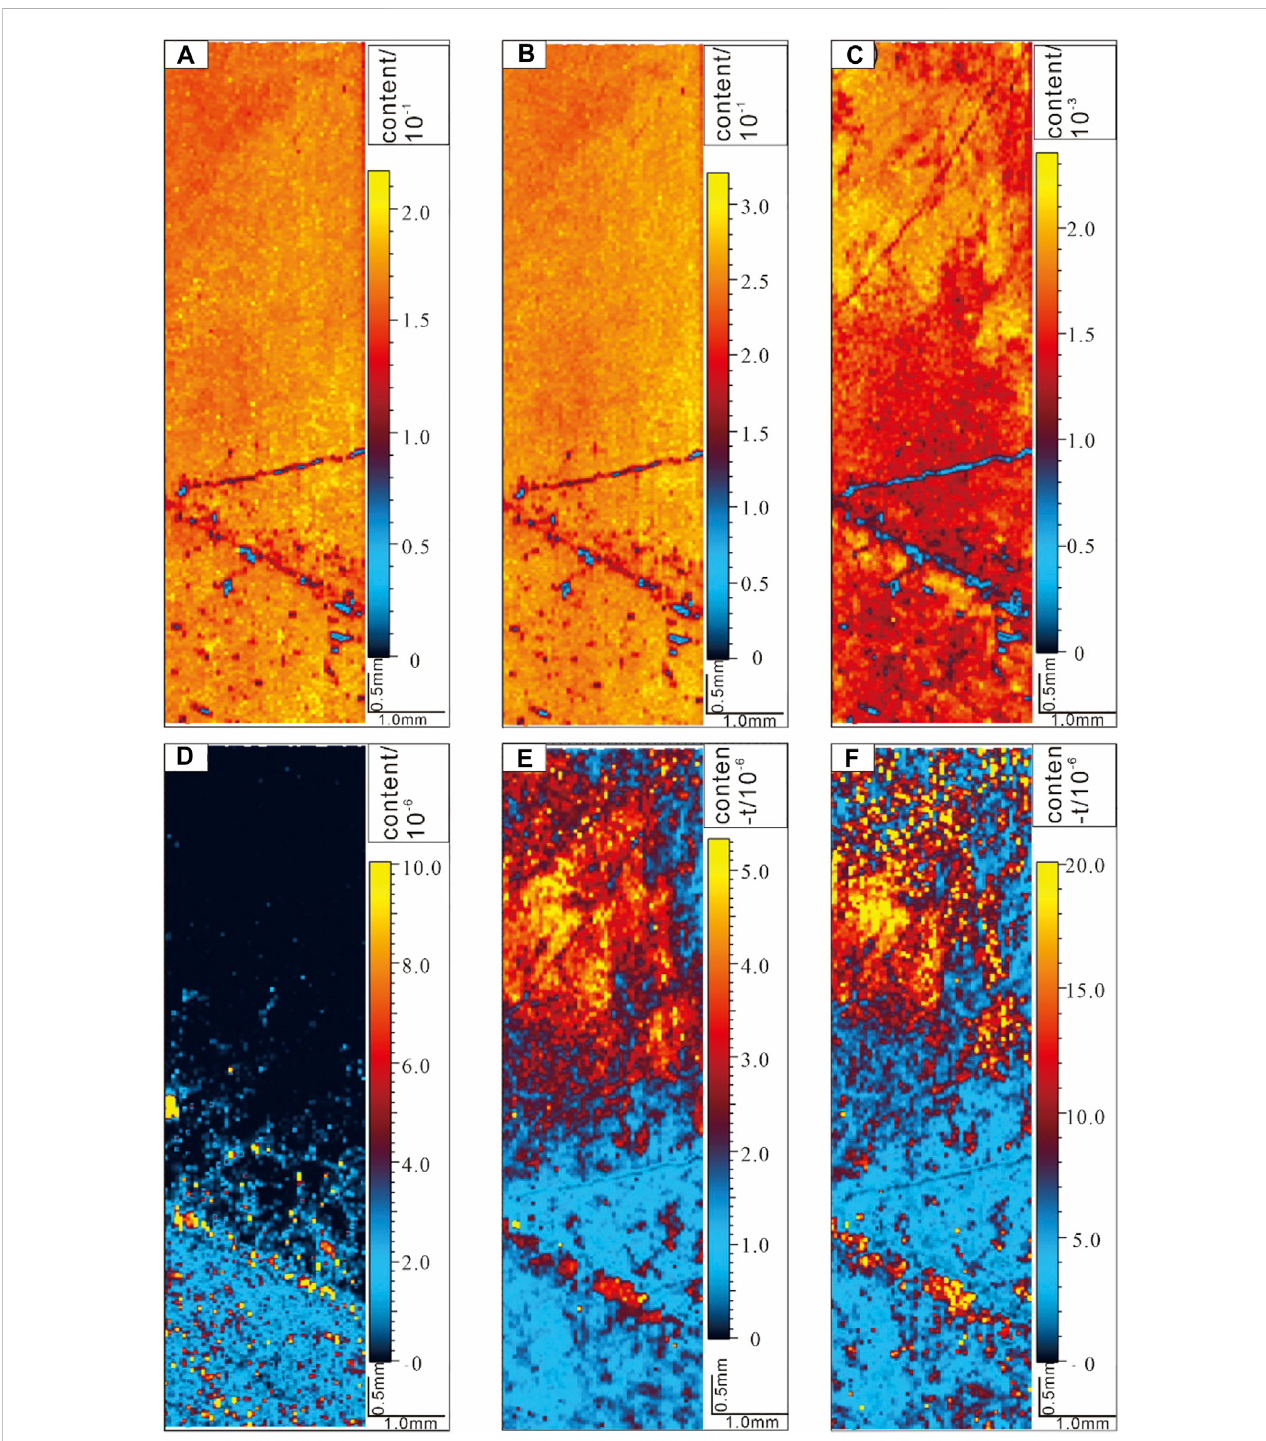
FIGURE 5 Element surface scanning images of Sample DQ11 in the Tarim Basin. (A) . Concentration of 25 Mg in horizontal distribution; (B) concentration of 43 Ca in horizontal distribution; (C) concentration of 55 Mn in horizontal distribution; (D) concentration of 238 U in horizontal distribution; (E) concentration of 89 Y in horizontal distribution; (F) concentration of 140 Ce in horizontal